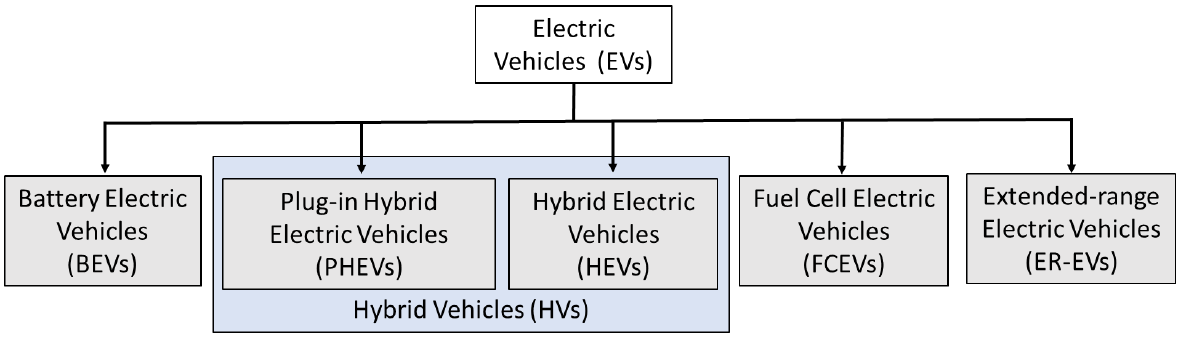
Figure 3. Electric vehicles classification according to their engine technologies and